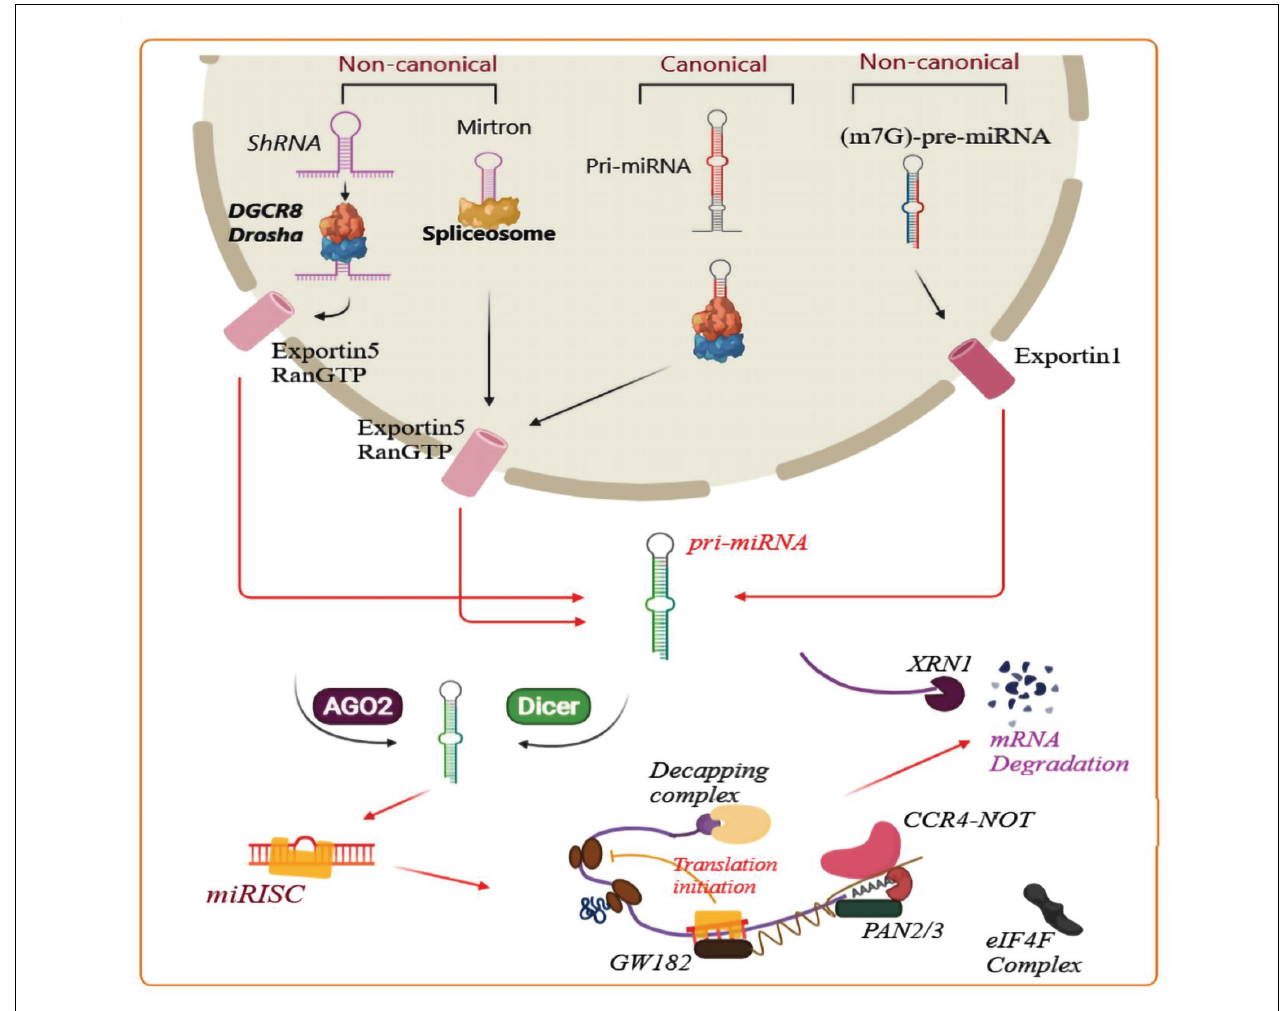
FIGURE 2 | Biogenesis of microRNAs and related mechanisms. A pri-miRNA transcript is the first stage of canonical miRNA biogenesis, which is cleaved by a micro-processor complex (containing Drosha and DGCR8), to create the precursor-miRNA (pre-miRNA). Then, the Exportin5/RanGTP-dependent pathway transports the pre-miRNA to the cytoplasm and processes it to produce a mature miRNA duplex. In the next step, the 5p or 3p strand of the mature miRNA duplex is loaded into a member of the Argonaute (AGO) family of proteins to form a miRNA-induced silencing complex (miRISC). Next, the small hairpin RNA (shRNA) is cleaved in a non-canonical pathway, and Exportin5/RanGTP transports it to the cytoplasm and processes it through an AGO2-dependent, but Dicer-independent cleavage mechanism. 7-Methylguanine capped (m7G)-pre-miRNA and mirtrons depend on Dicer for completing their cytoplasmic maturation, however there are differences in their nucleocytoplasmic shuttling. Exportin5/RanGTP exports mirtrons whereas Exportin1/m7G exports pre-miRNAs. Each pathway results in a functional miRISC complex which can recognize its target mRNA to induce translational suppression via interference with the eIF4F complex. Then, the poly(A)-deadenylases PAN2/3 and CCR4-NOT are recruited by the GW182 family protein attached to Argonaute, and PAN2/3 starts deadenylation while this process is completed by the CCR4-NOT complex, and finally the m7G cap on the target mRNA is removed via the decapping complex. Finally, the decapped mRNA undergoes 5 (cid:48) -3 (cid:48) degradation through exoribonuclease XRN1 (modified from the results reported in Hayder et al. (2018)